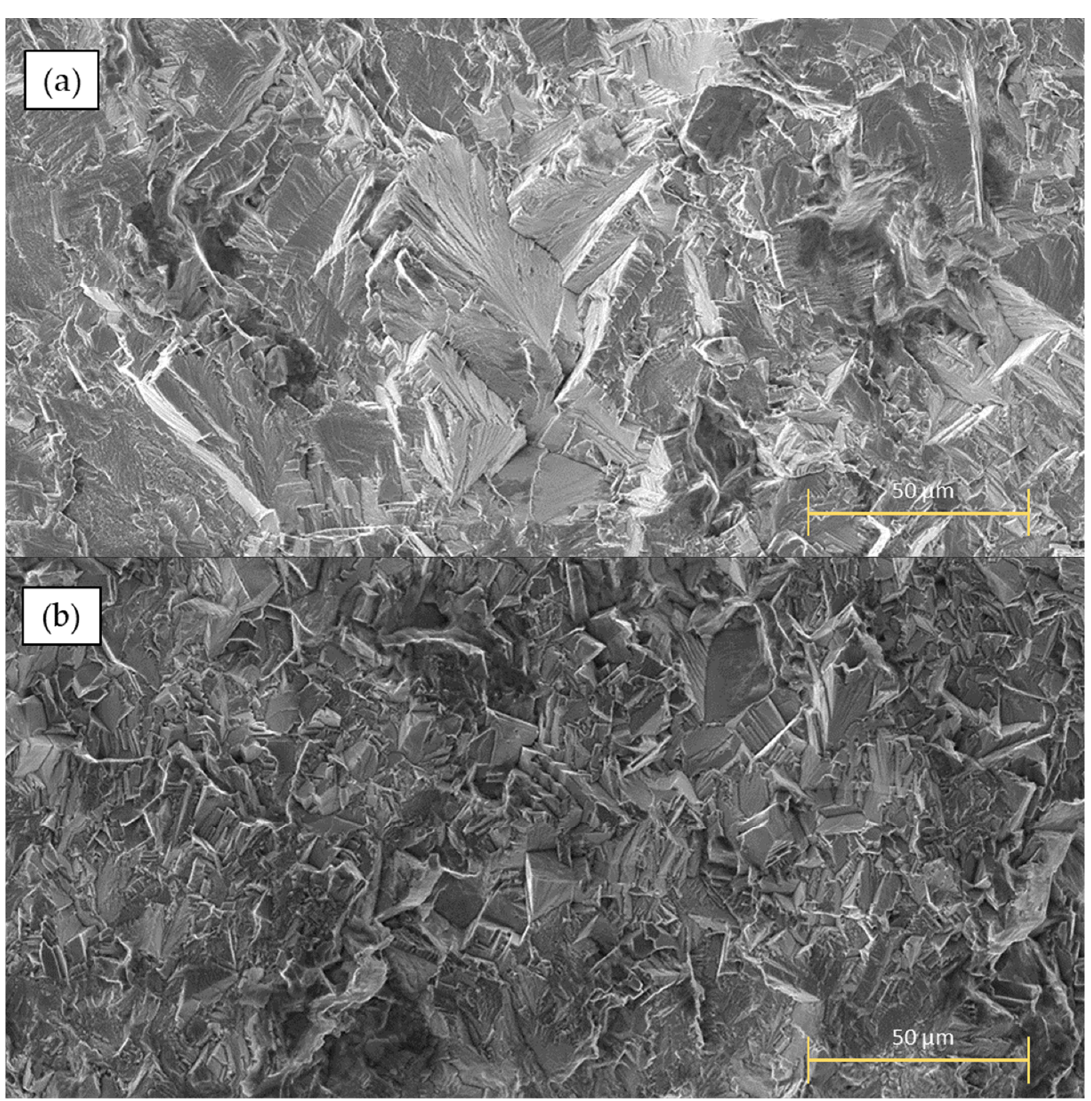
Figure 8. Grain size inhomogeneity of Material B from crack propagation samples with increasing Δ K: R = 0.1; ( a ) coarse area—ALA grains, ( b ) homogeneous fine microstructure.